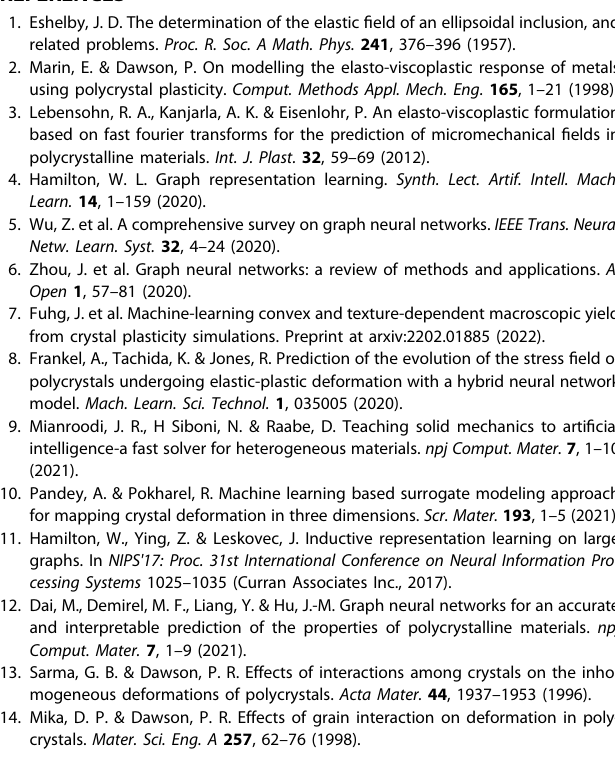
of a surrogate model for 10,000 epochs nominally takes 2 – 15 min depending on the amount of training data (1500 grains to 3000 grains) using an NVIDIA Quaddro GPU with 5 GB of memory. DATA AVAILABILITY Data will be made available by the authors upon request.